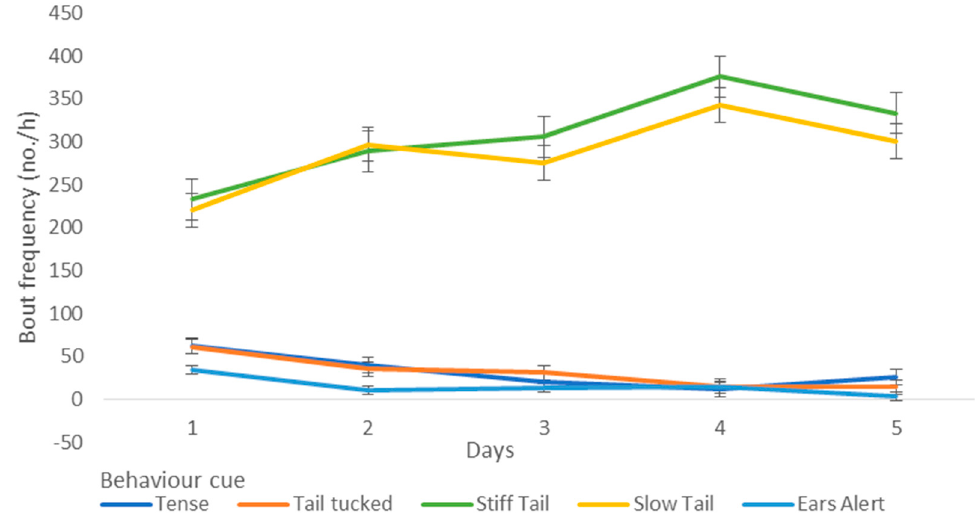
Figure 1. The frequency of fear-related behaviours, alert ears, and tail behaviours over the first five days that dogs ( n = 38) spent in a shelter.